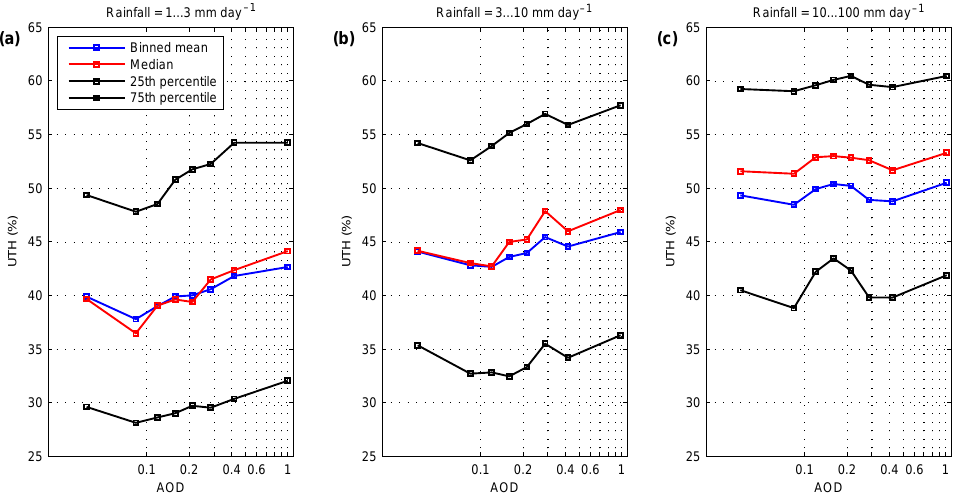
Figure 7. Results in three precipitation categories. UTH as a function of AOD (on a logarithmic scale) in three precipitation categories: (a) 1– 3mmday − 1 , (b) 3–10mmday − 1 and (c) 10–100mmday − 1 , east of China in June, July and August in 2007–2013. In each precipitation category, the AOD data were split into 8 bins, after which the 25th, 50th and 75th percentiles of the data and mean UTH of 10 precipitation bins were calculated. The cirrus dependence has been removed from the AOD